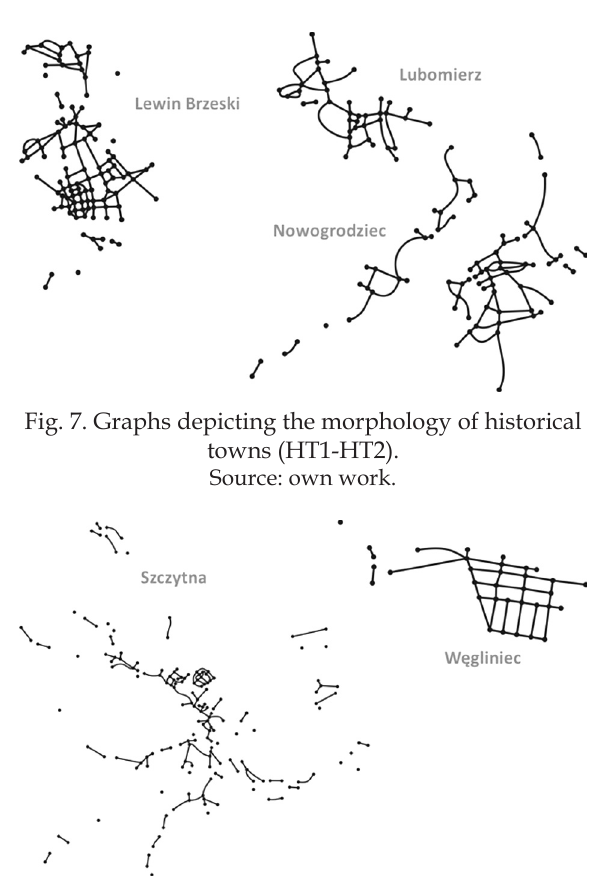
Fig. 8. Graphs depicting the morphology of new towns (NT). Source: own work.